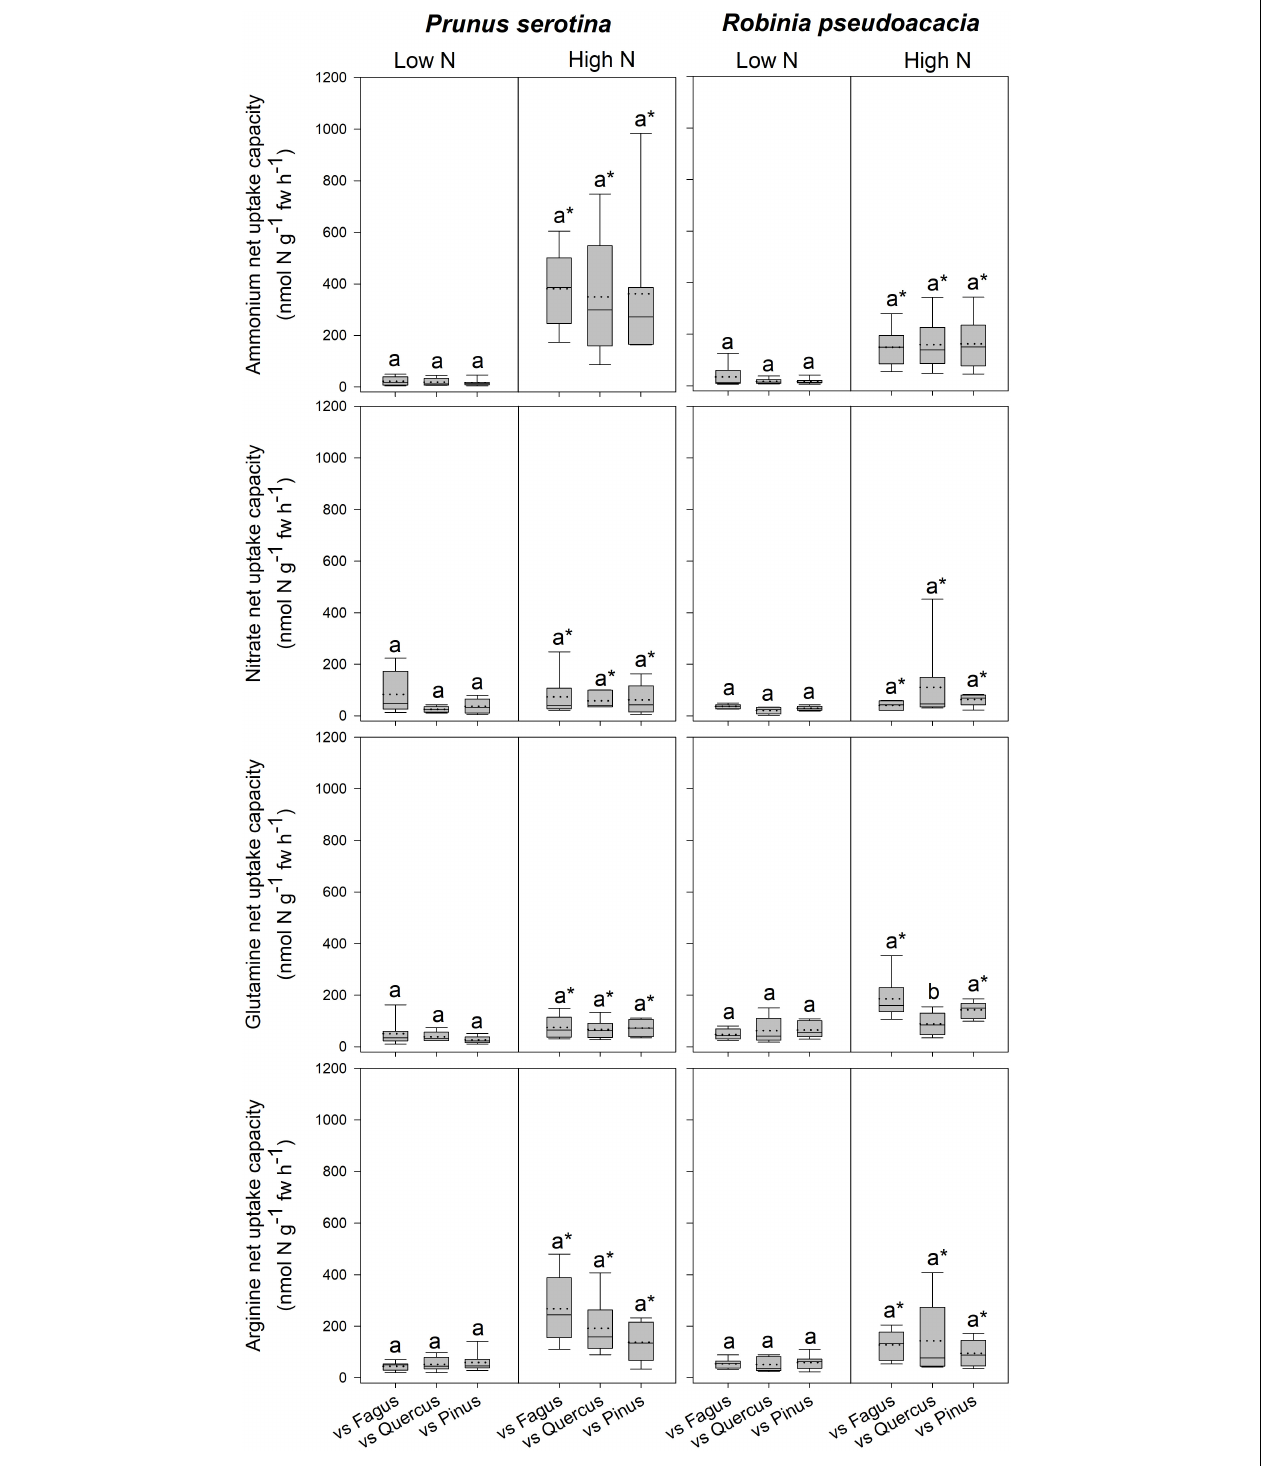
FIGURE 2 | Ammonium, nitrate, glutamine-N, and arginine-N net uptake capacity (nmol N g − 1 fw h − 1 ) by fine roots of Prunus serotina and Robinia pseudoacacia seedlings at low and high soil N availability under different competition regimes. vs. Fagus = competition with Fagus sylvatica ; vs. Quercus = competition with Quercus robur ; vs. Pinus = competition with Pinus sylvestris . Box plots show mean (dotted line) and median (continuous line). Different letters indicate significant differences between competition regimes within a specific soil N availability treatment, and asterisks indicate significant differences between soil N availability treatments detected using permutational analysis of variance ( p <